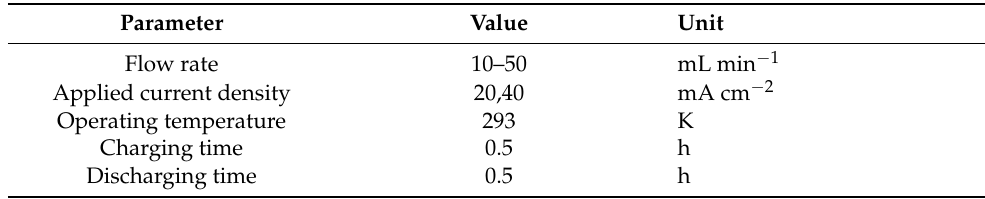
Table 2. Boundary